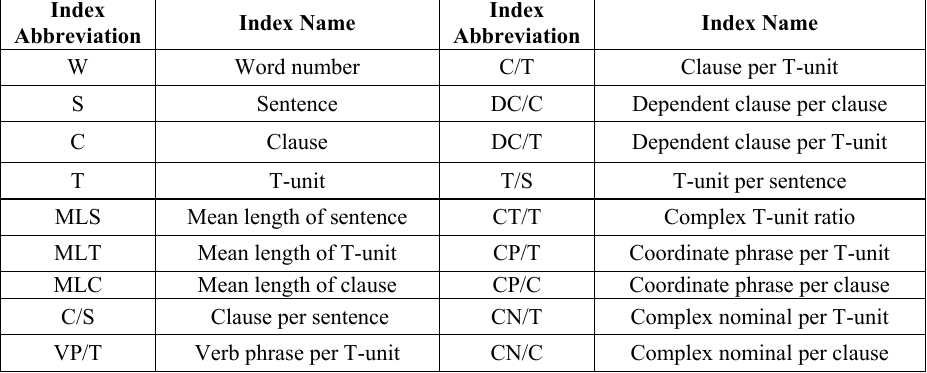
Table 1. Syntactic complexity indices concerned in the